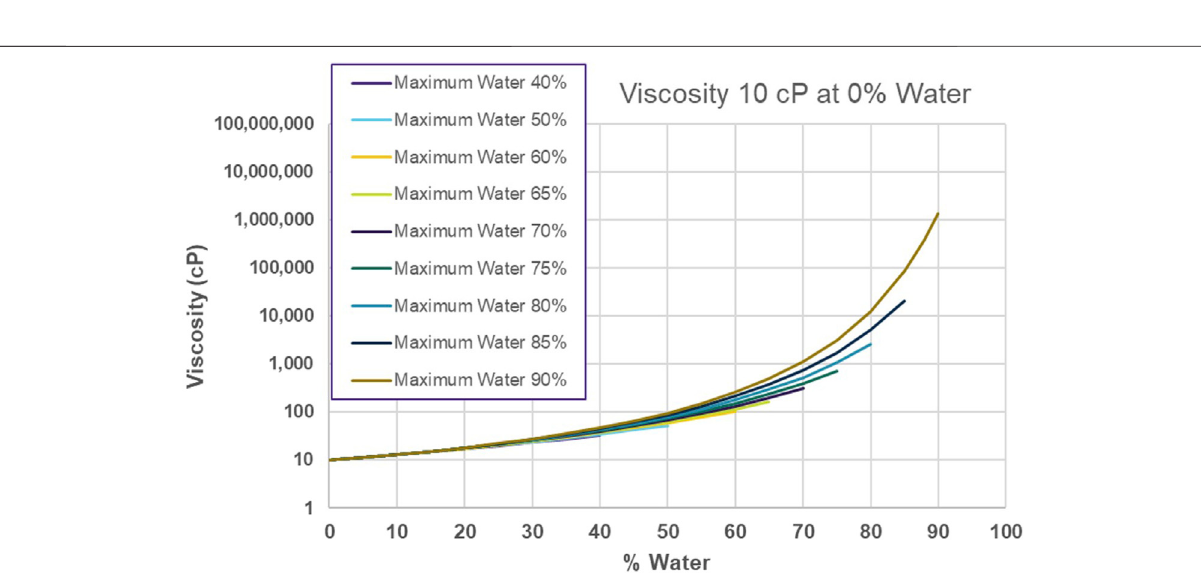
Frontiers in Environmental Science |